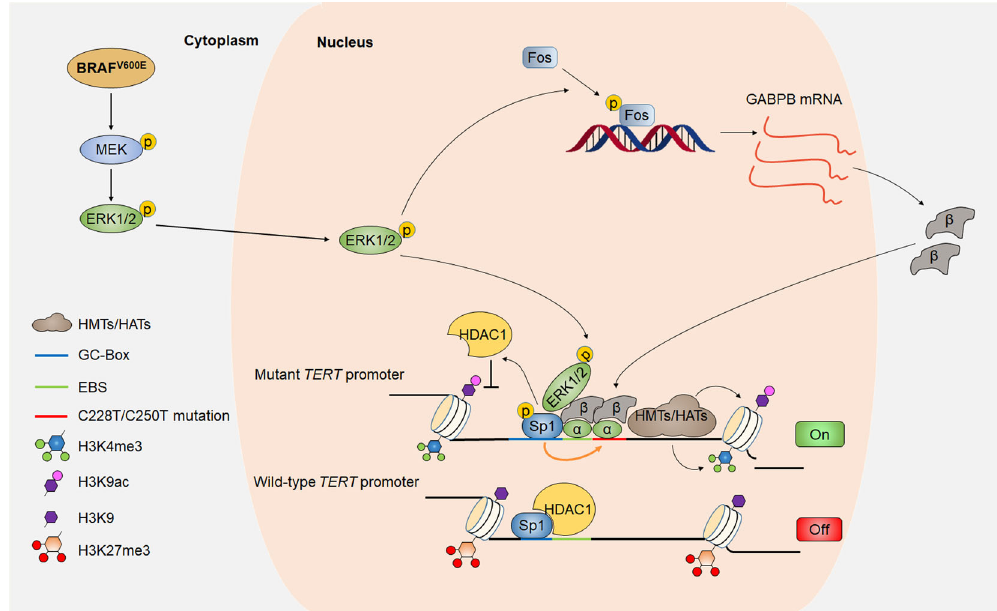
Fig. 8 A schematic model showing the activation of the mutant TERT promoter by the synergistic interaction between Sp1 and GABPA. In BRAF V600E -driven cancer cells, GABP tetramer mediates the recruitment of activated ERK to mutant TERT promoter. In turn, activated ERK facilitates the interaction between Sp1 and GABPA by phosphorylating Sp1 and subsequently promoting HDAC1 dissociation from Sp1/ HDAC1 complex, further enhancing the binding of GABPA to mutant TERT promoter. Synergistic interaction between Sp1 and GABPA will maintain an active chromatin state in mutant TERT